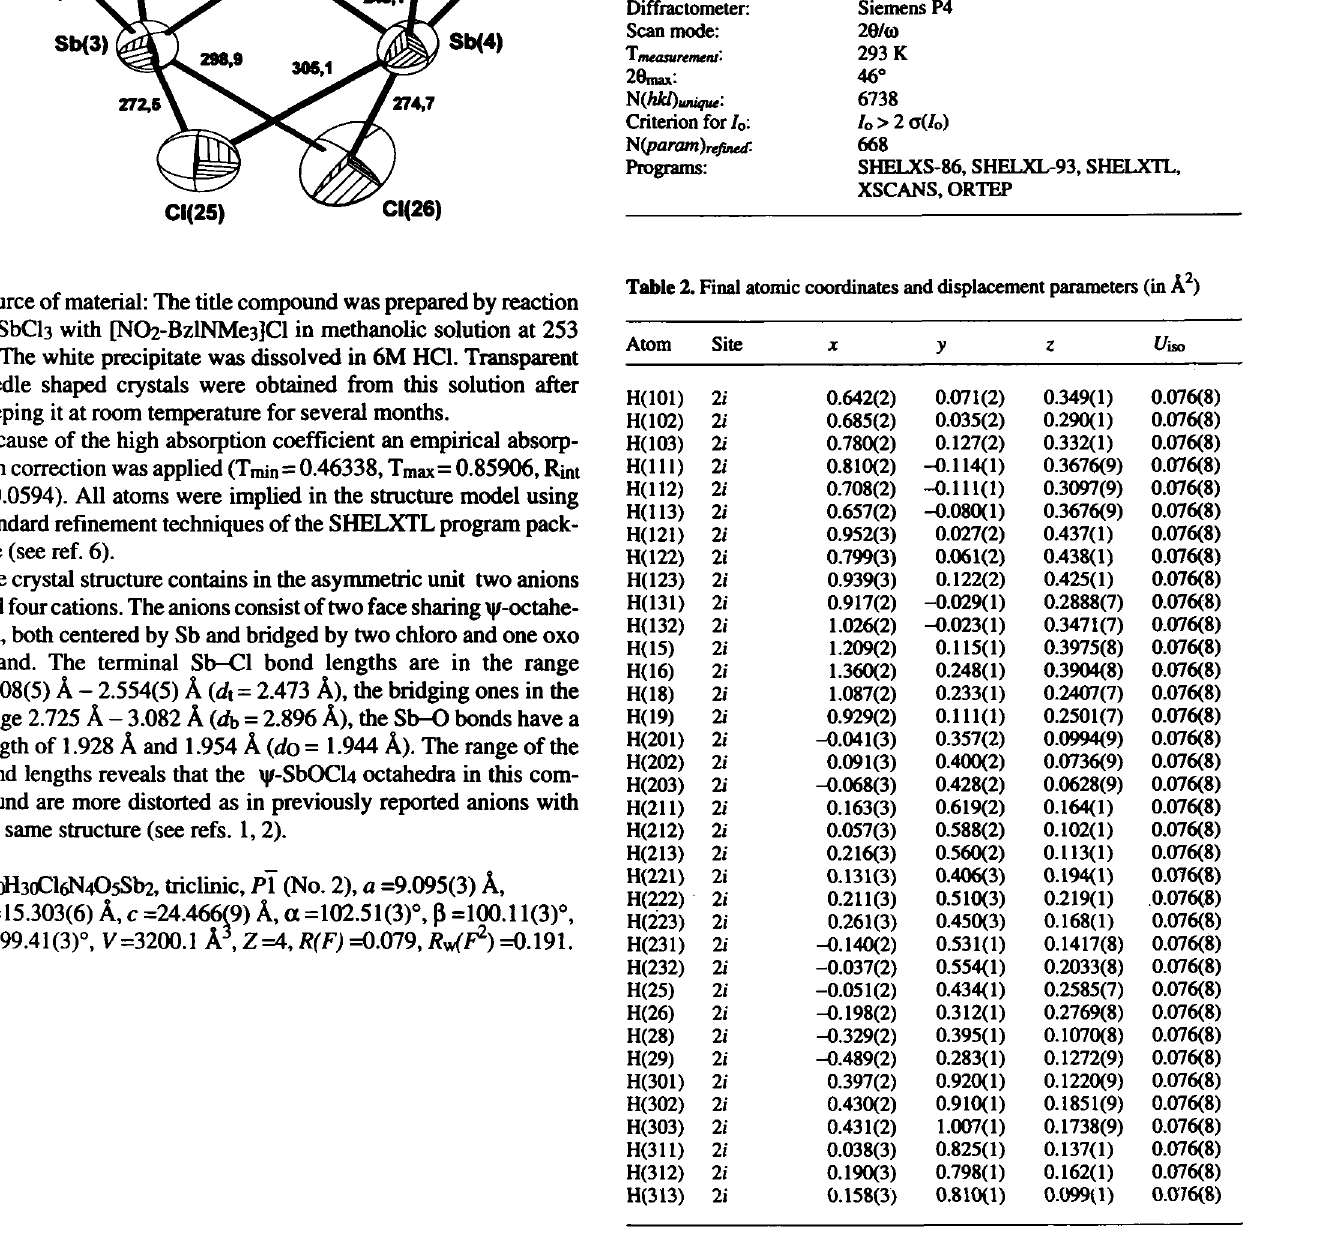
Table 1. Parameters used for the X-ray data collection